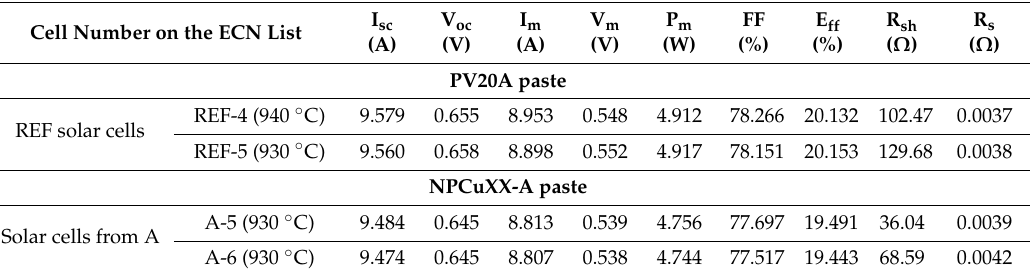
Table 4. The current-voltage (I-V) parameters of the 244 cm 2 , Cz-Si, PERC solar cells area of 244 cm 2 fabricated by application of the NPCuXX paste for front electrode by a screen-printing technique and co-fired at 930 ◦ C and 940 ◦ C.